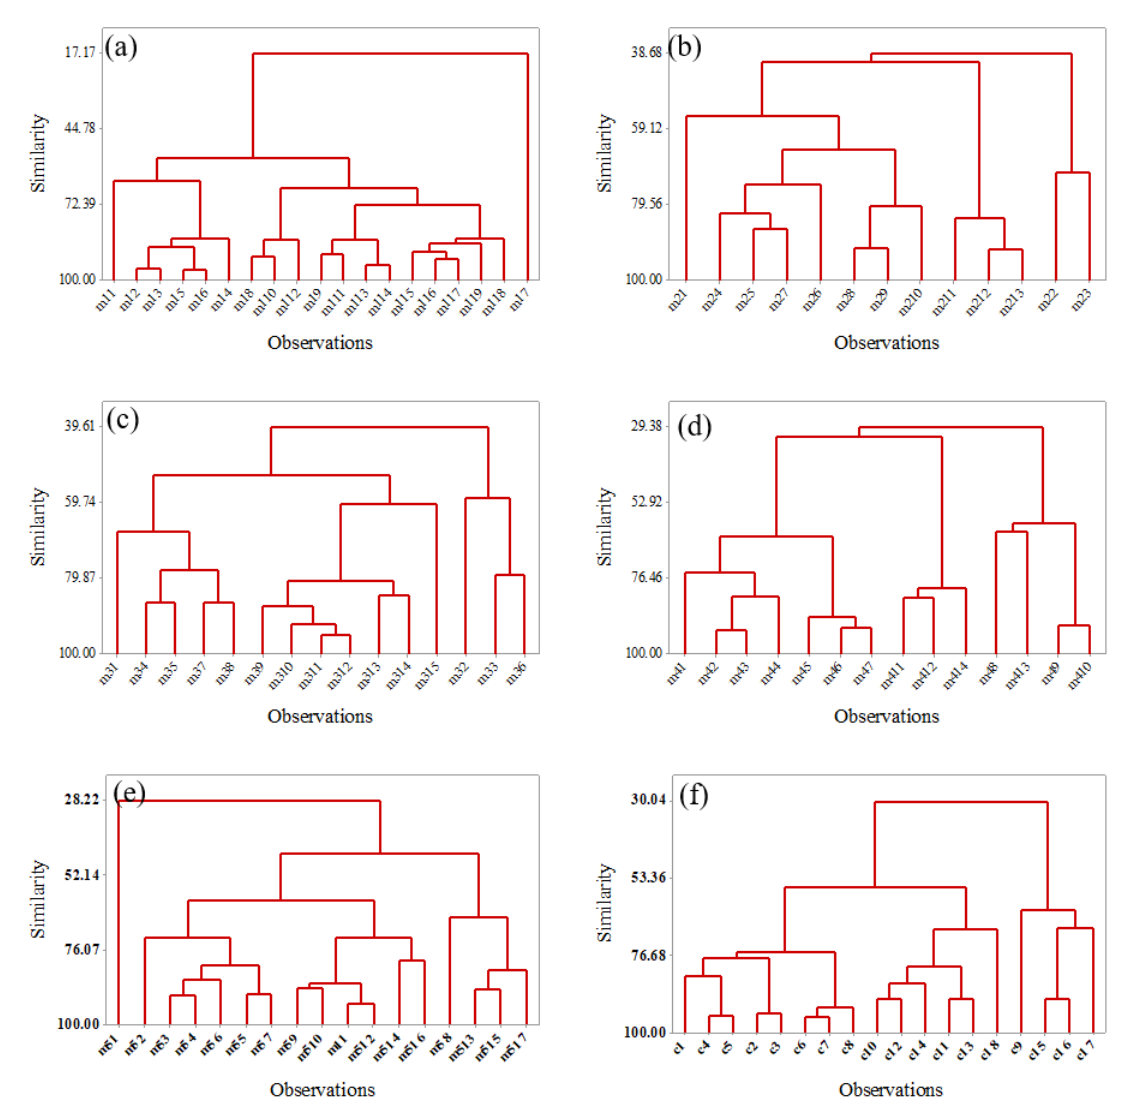
Figure 2: Dendrograms showing similarity between the bacterial strains isolated from the modified NA medium by adding (a) 40% (M1), (b) 32% (M2), (c) 24% (M3), (d) 16% (M4), (e) 8% (M5) (v/v) of soil extract obtained from the landfill soil and (f) the control (unmodified